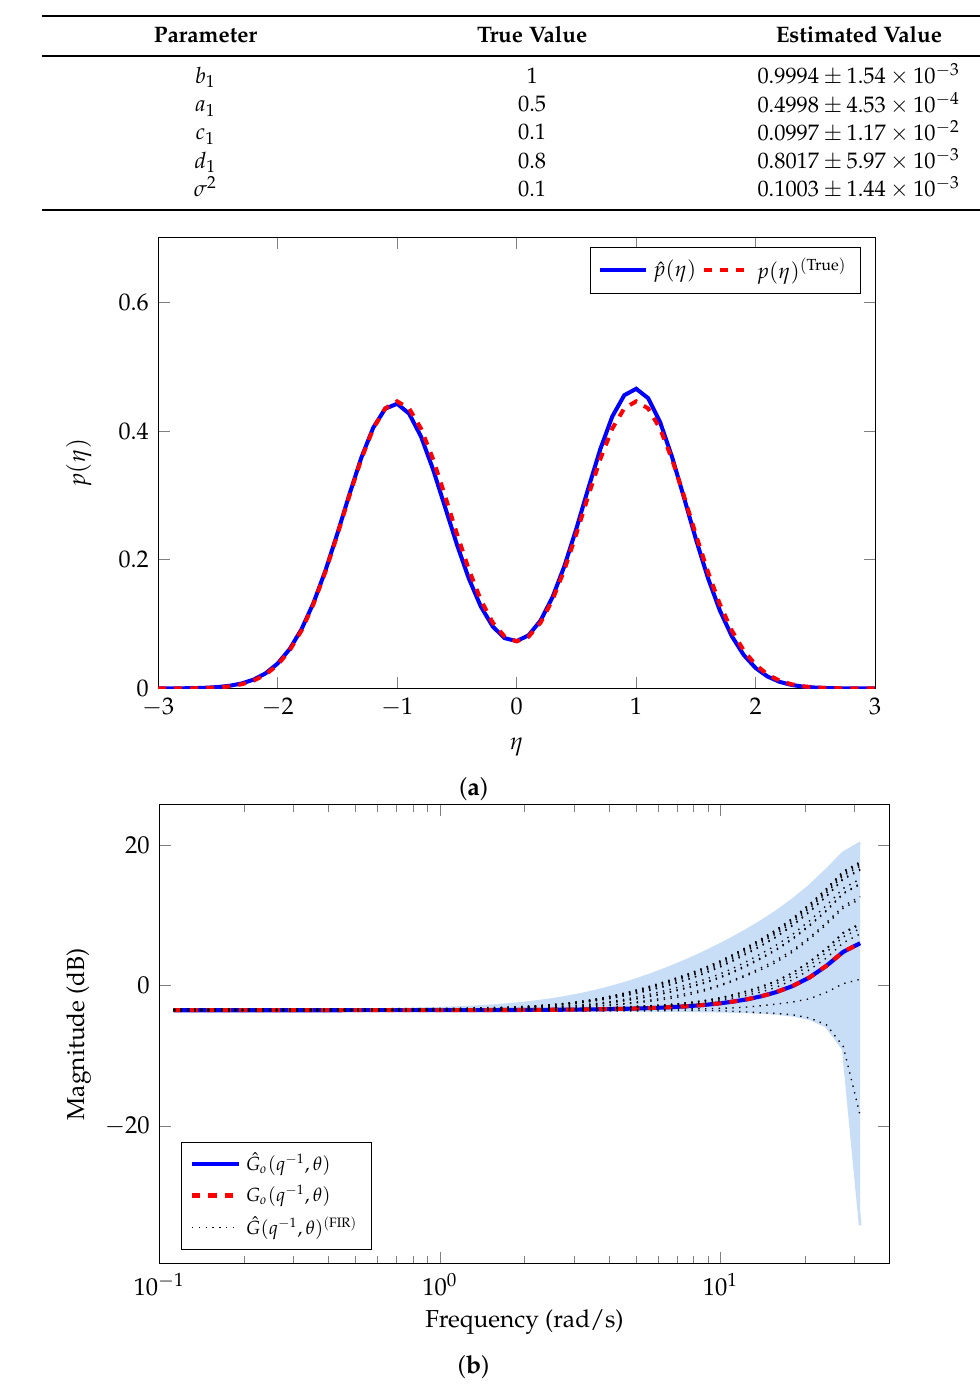
Table 1. Nominal model parameters and noise variance estimated for Example 1.